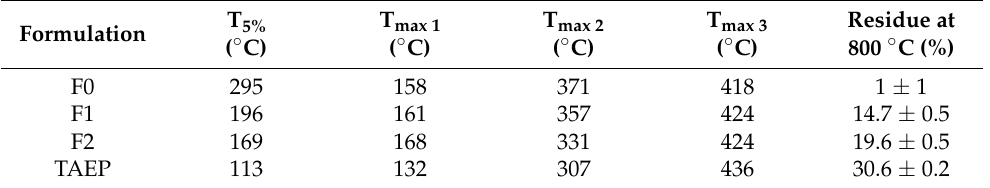
Table 3. Results of thermogravimetric analysis. T 5% corresponds to the temperature at which 5% of the sample mass is lost, T max 1 , T max 2 and T max 3 are the temperatures of the degradation rate maxima.